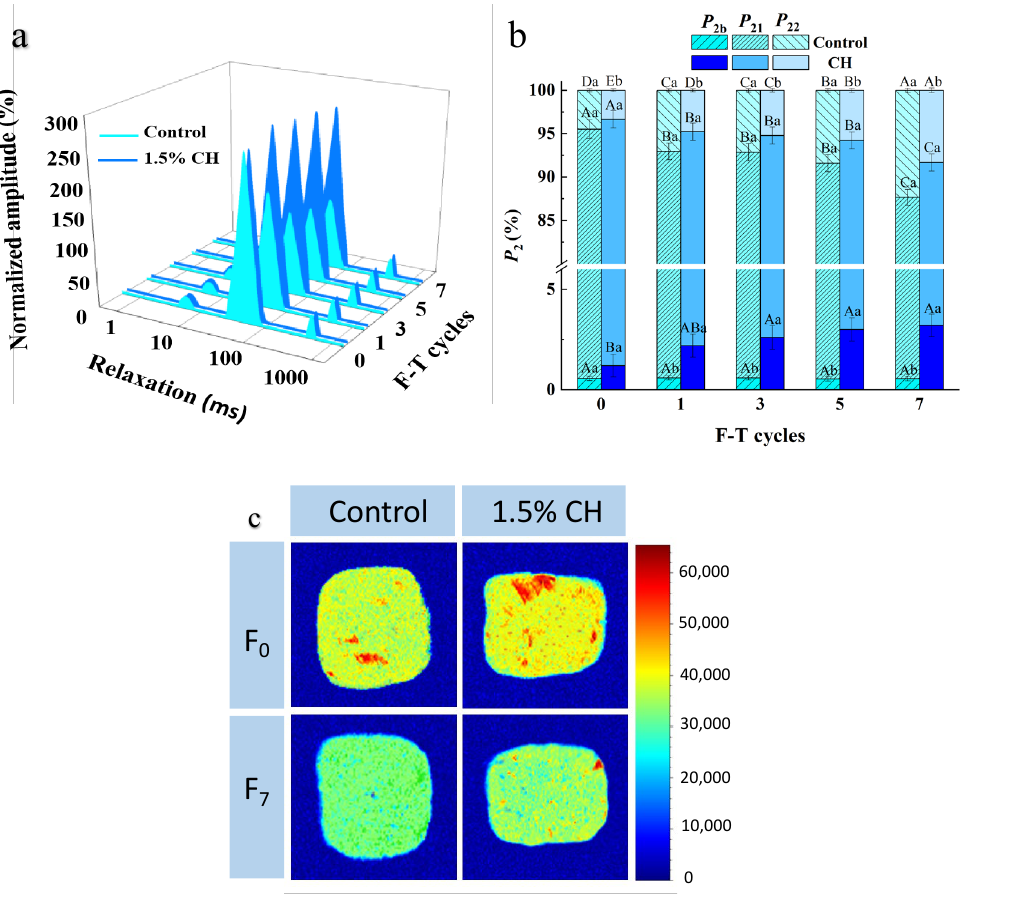
Figure 2. Influence of chitosan ice coating on the T 2 relaxation times ( a ) and P 2 ( b ) water content ( c ) of fish balls induced by freeze–thaw cycles. The means in the same treatment group with different uppercase letters (A–E) differ significantly ( p < 0.05); the means at the same freeze–thaw cycle with different lowercase letters (a–b) differ significantly ( p < 0.05). Table 4. Influence of chitosan ice coating on the T 2 relaxation times of fish balls induced by freeze– thaw